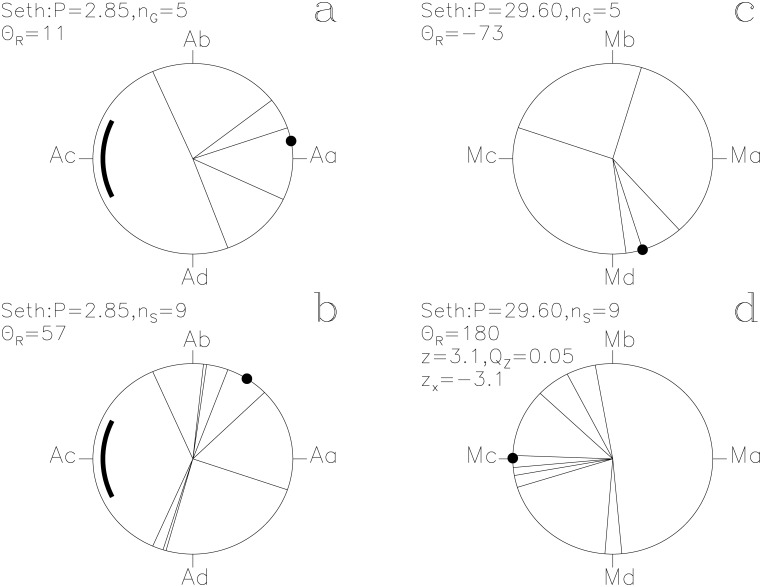
Seth.otherwise as in Fig 1